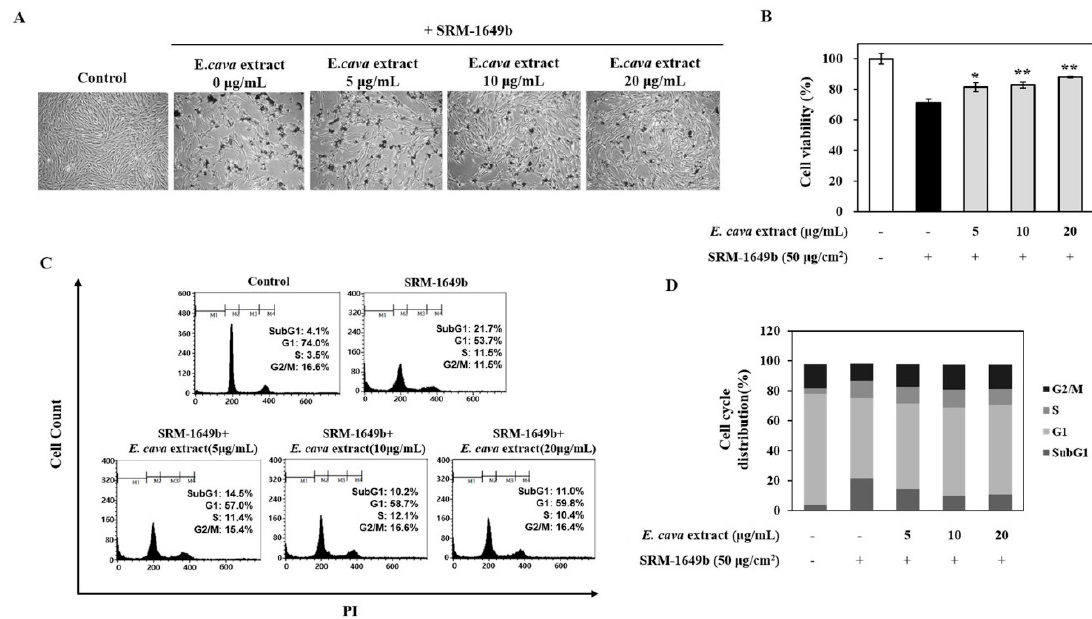
Figure 1. SRM-1649b-induced cytotoxicity was reduced by treatment with E. cava extract. Cell images of HFDPC with E. cava extract added after SRM-1649b treatment ( A ). Quantified viability ( B ). The apoptotic effect induced by SRM-1649b was rescued by E. cava extract and it was confirmed in cell cycle analysis using flow cytometry ( C ). Each cell cycle phase is shown graphically ( D ). Data are representative of three independent experiments and values are expressed as mean ± S.D (* p < 0.05, ** p < 0.01).